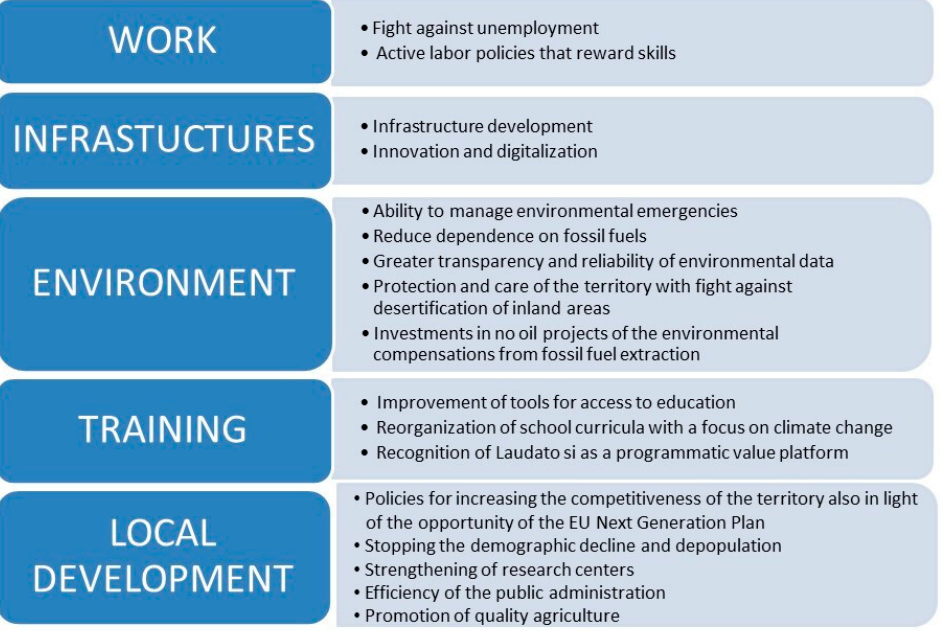
Figure 5. The most urgent challenges identified by the territorial survey.